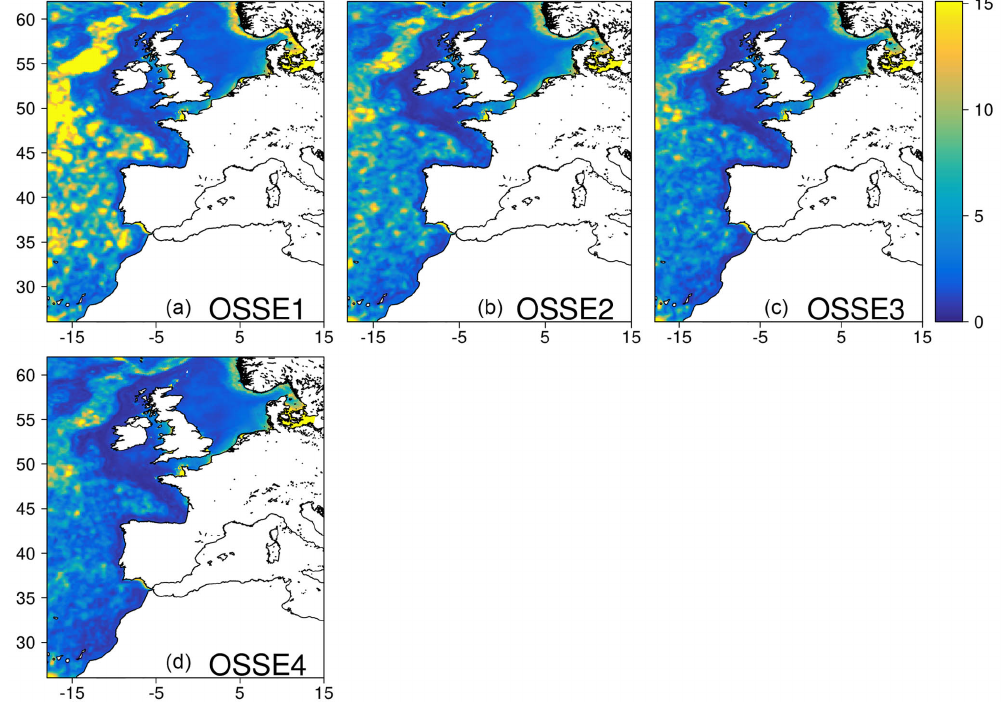
Figure 6. Maps of the variance of SSH error in the ocean analysis over the IBI domain during the period from February to December 2009. The results are obtained by comparing the SSH of the NR with the ocean analysis of the OSSE1 (a) , OSSE2 (b) , OSSE3 (c) and OSSE4 (d) experiments. Values expressed as square centimetres (cm 2 ).